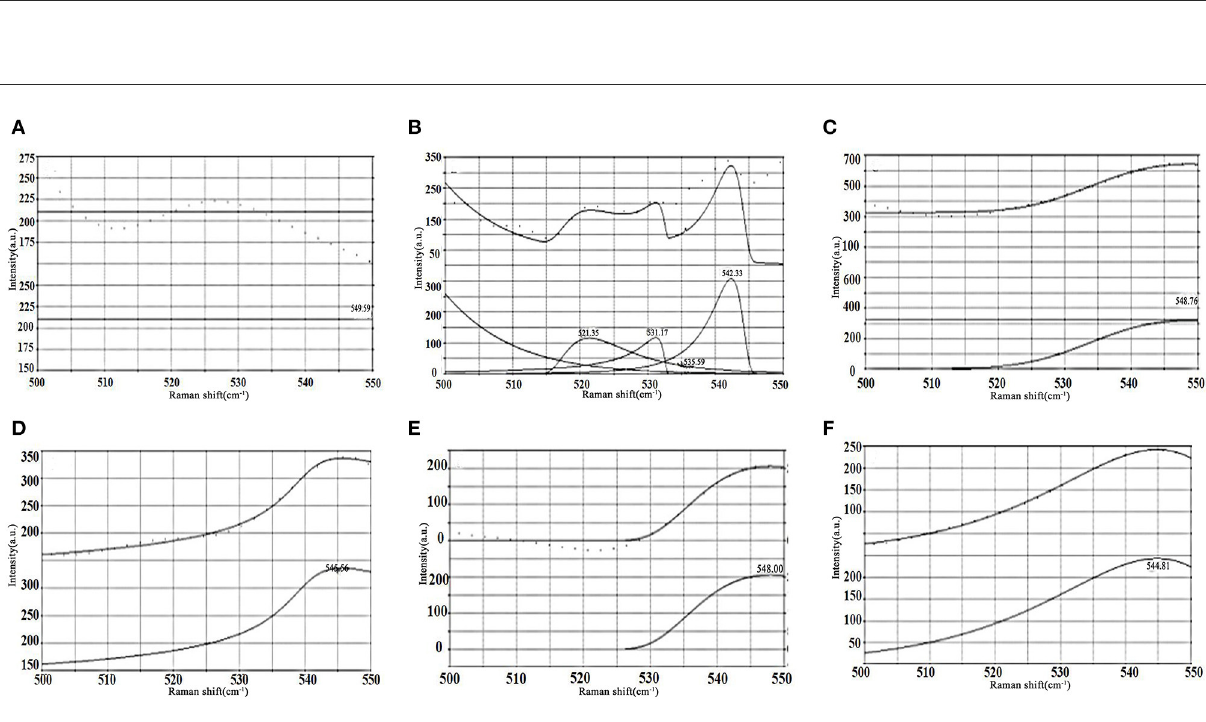
FrontiersinNutrition